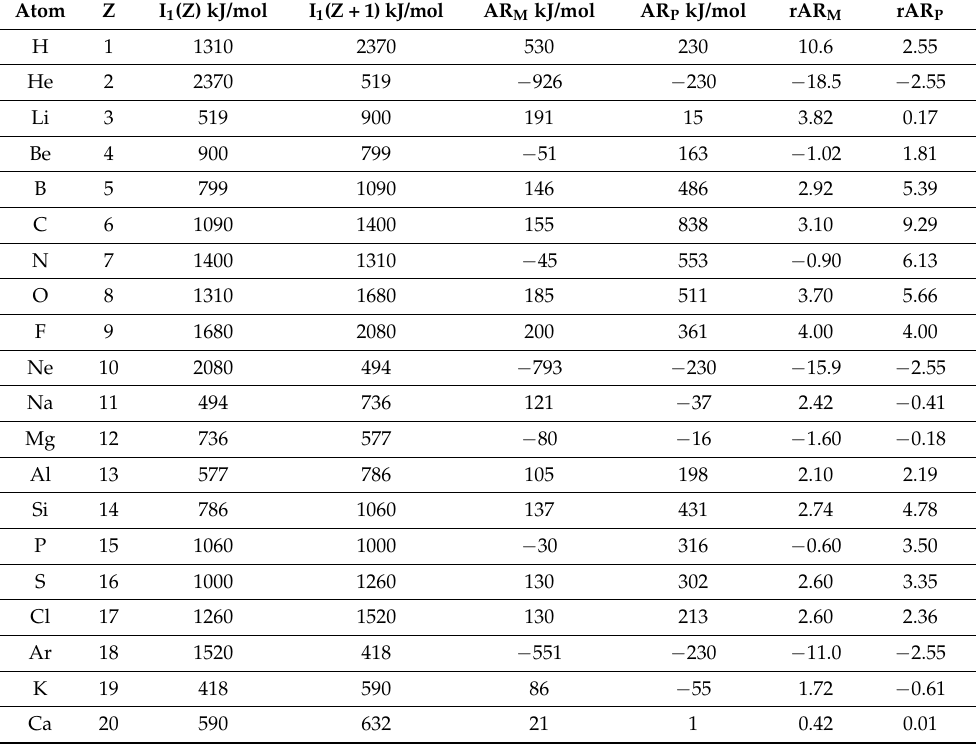
Table 1. First ionization energies and reactivity measures for atoms H, He and Ca developed according to reasoning of Mulliken (AR M ) and Pauling (AR P ). Note that Z is the atomic number and the inert gas atoms have only nominal reactivities AR P and rAR P based on vanishing atomization energies for the dimers HeH, NeH and